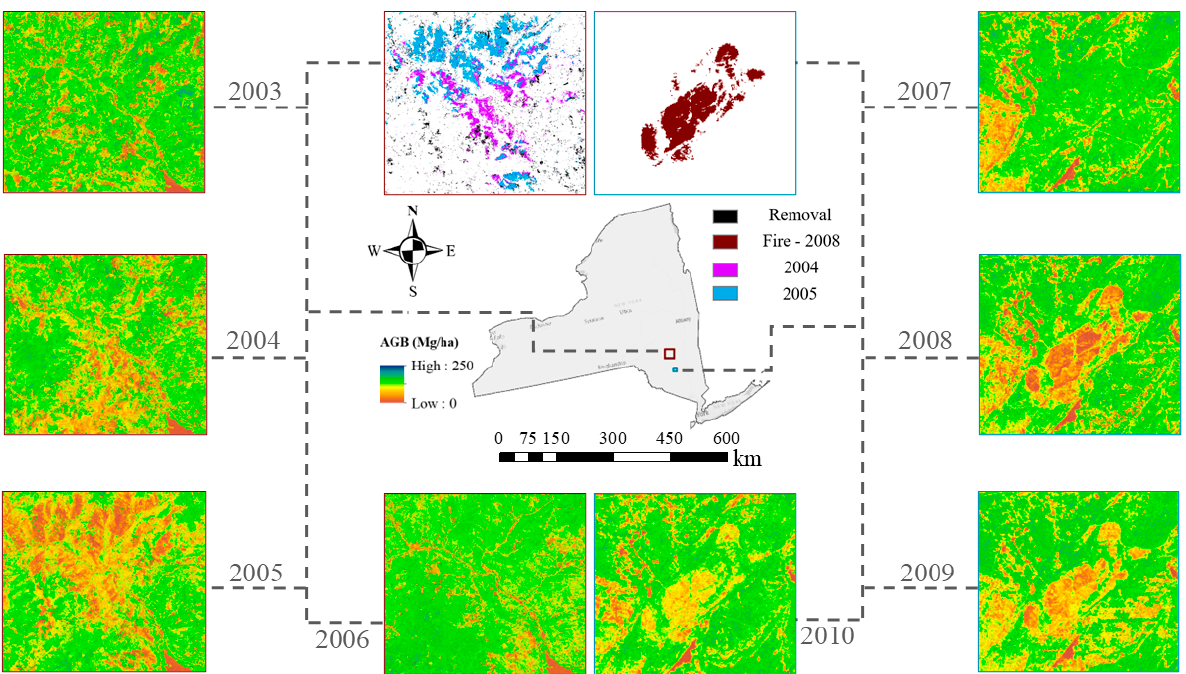
Figure 7. Two zoomed areas for demonstrating the forest disturbance (left: forest removal in 2004 and 2005; right: forest fire in 2008).